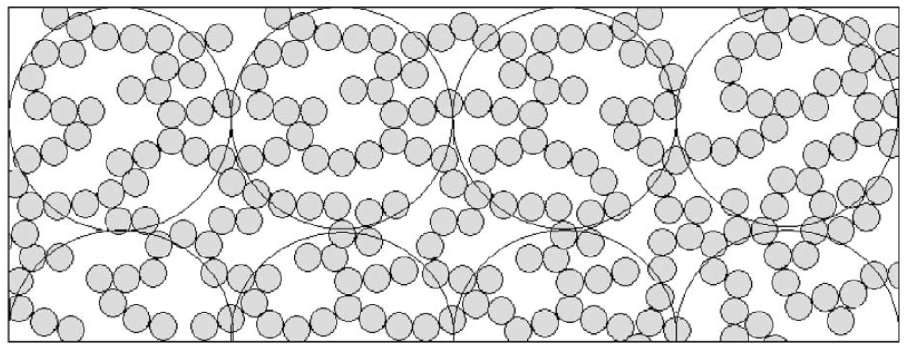
Figure 8. Formation of a weak gel in which most of the particles are weakly bound to the network. Larger circles represent the fractal ‘blob’ concept. Reproduced with permission from [Horne, D.S.], [Banks, J. Rennet-induced Coagulation of Milk. In Cheese Chemistry, Physics and Microbiology ]; published by [Elsevier],